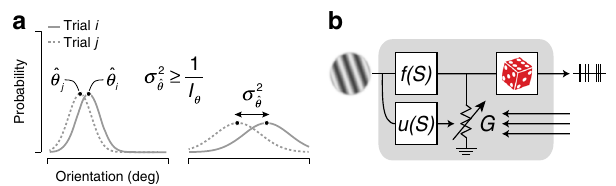
Fig. 1 Encoding information for perceptual tasks. a An effective strategy for estimating a perceptual quantity such as local image orientation is to compute the likelihood of each possible stimulus value (gray lines) and choose the most likely option ( ^ θ , black dots). Due to noise, this value will differ across trials (full vs dotted lines, ^ θ i vs ^ θ j ). The larger the uncertainty of the sensory information, the wider the likelihood function, and the greater the variance in the perceptual estimate (left vs right panel). The variance of this maximum-likelihood estimate σ 2 ^ is larger than or equal to θ the inverse of the Fisher information I θ 20 . b Schematic summarizing the proposed model. Spikes arise from a Poisson process whose rate is the product of a deterministic drive f ( S ) and a stochastic gain G . f ( ⋅ ) governs the mapping of stimulus features onto drive and hence controls response mean; u ( ⋅ ) governs the mapping of stimulus uncertainty onto gain variability and hence controls response